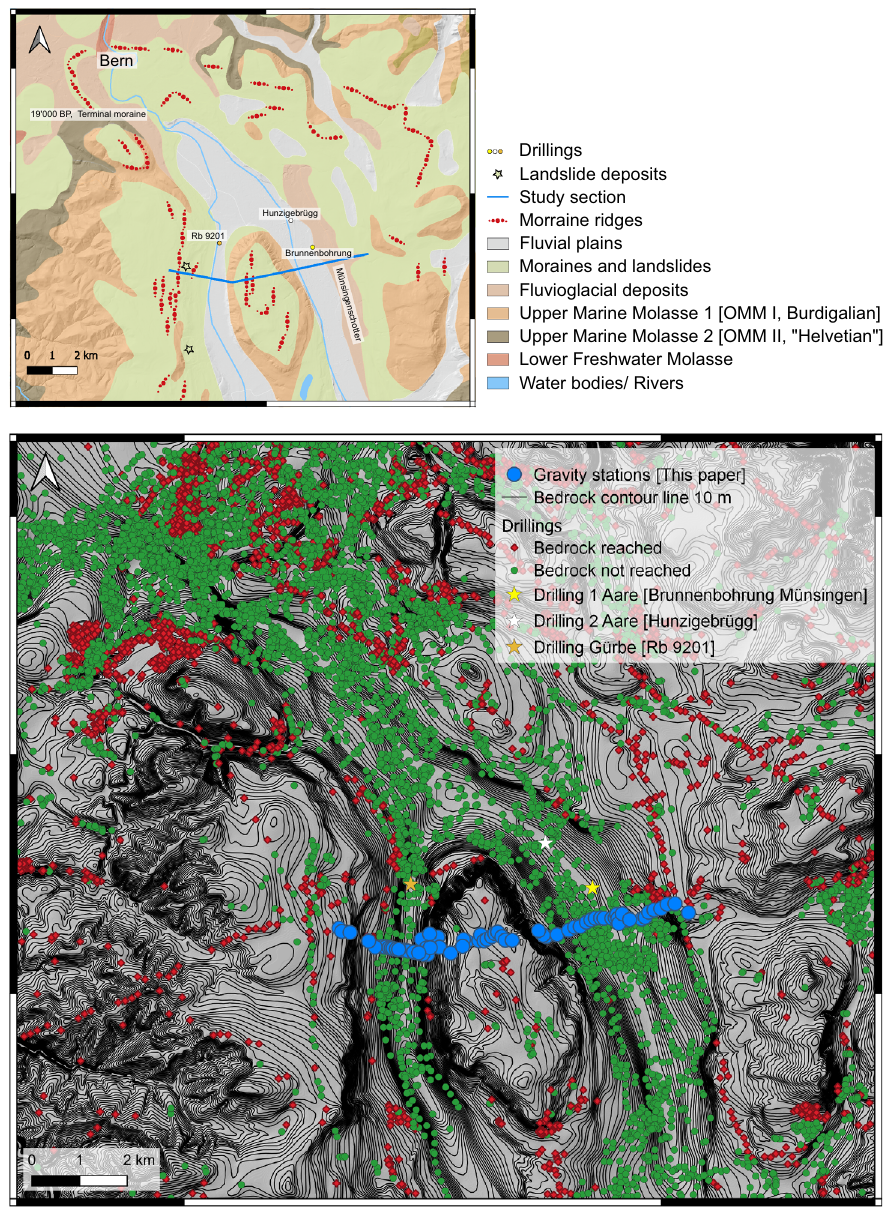
Figure 2. Geology of the region. ( a ) Geological map 22,25 , showing LGM moraines, pre-LGM gravel (Münsingenschotter), landslides deposits on the western flank of the Gürbe valley, the bedrock lithology, and the Holocene deposits covering the Aare and Gürbe valley floors. The bedrock overlying the Aare and Gürbe overdeepenings comprise a monotonous sequence of Burdigalian Upper Marine Molasse sandstones 22,25 . This map was obtained and modified from the openly accessible database of swisstopo (© swisstopo). ( b ) Map showing the contour lines (equidistance of 10 m) of the bedrock underneath the Quaternary cover. This map was reproduced using the openly accessible digital dataset for the bedrock topography of the canton Bern (https:// www. geo. apps. be. ch/ de/; Karten; Felsrelief), and it is also available from the openly accessible database of swisstopo (© swisstopo). This dataset was originally produced by Reber and Schlunegger 12 . Some drillings did reach the bedrock (red dots) and thus offer good constraints on the bedrock topography. Most of the drillings, however, did not reach the bedrock and yield minimum constraints on the depths of the overdeepening contour lines (green dots). The map has an uncertainty between 20 and 50 m. The blue dots illustrate the location of the stations that are used in this study. This map is also available from the openly accessible database of swisstopo (©